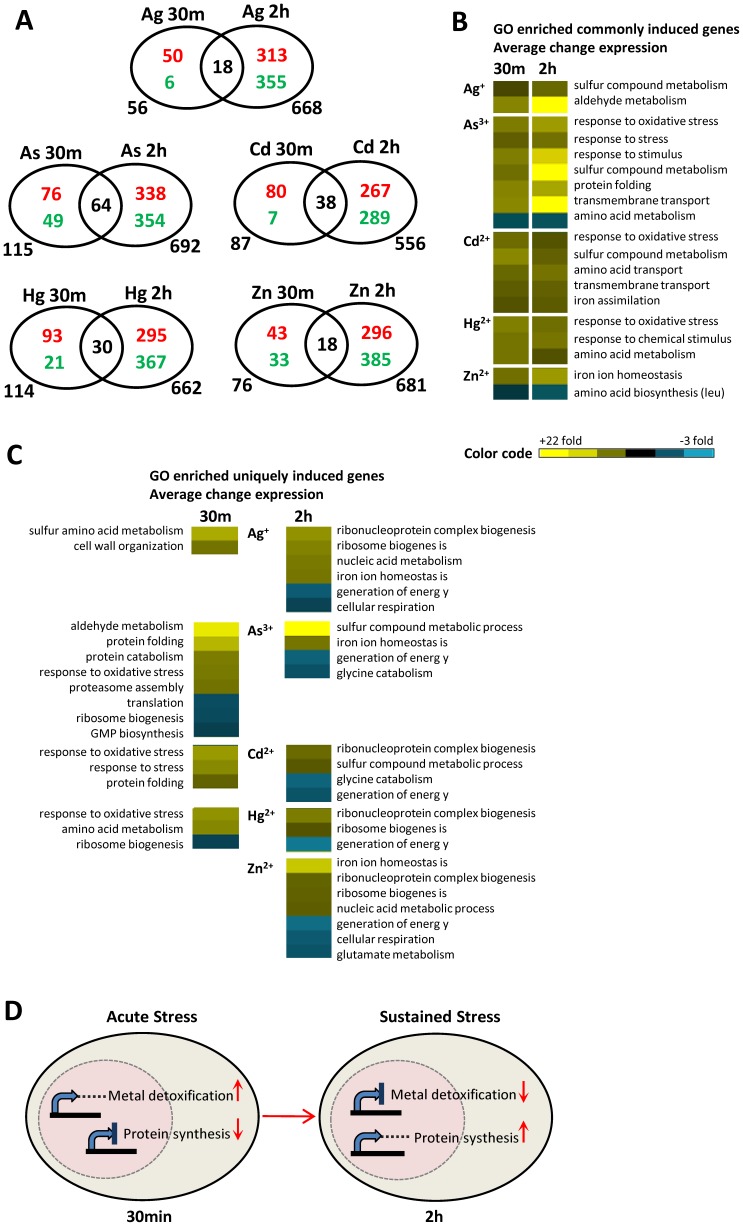
Comparison of expression patterns upon acute and sustained metal stress.
A) Venn diagrams illustrate the distribution of transcriptionally up-regulated (red) and down-regulated (green) genes from metal-stressed BYwt cells (30 min - acute stress; 2 h – sustained stress; additional information is provided in TS 1 and 2 in File S4). B) and C) Analysis of genes of both data sets via T Profiler associated to significant GO terms; variations in transcript abundance for each significant GO pathway under the particular metal stress conditions were calculated as mean values of fold inductions and repressions; up-regulated genes (yellow), down-regulated genes (blue); detailed information is provided in TS 3, 4, 5, and 6 in File S4. B) overlapping genes; C) genes expressed in one set. D) In response to acute metal stress (30 min) transcription of protein synthesis is inhibited (↓) to divert energy to the transcription of metal detoxification (↑). Under sustained metal stress (2 h) transcription of metal detoxification pathways is deactivated (↓), whereas protein synthesis is reactivated (↑).